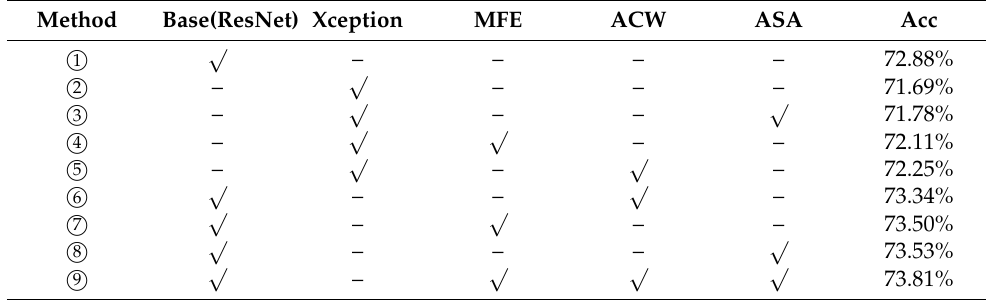
Table 1. Performance test of each